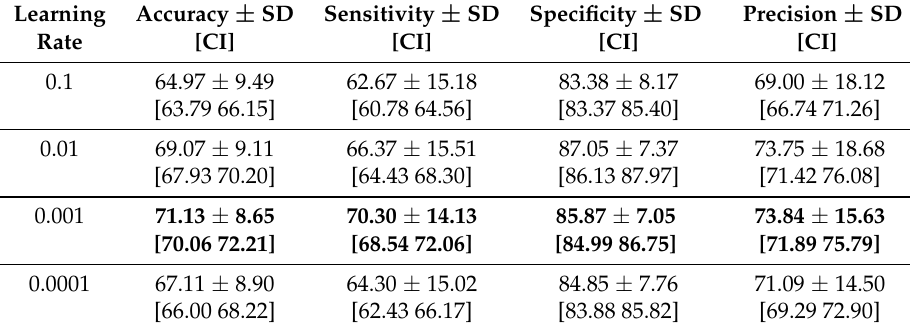
Table 3. Accuracy, Sensitivity, Specificity and Precision for Various Learning Rate Using LSTM. (The Numbers in Bold Indicate the Best Value Obtained for Each Quality